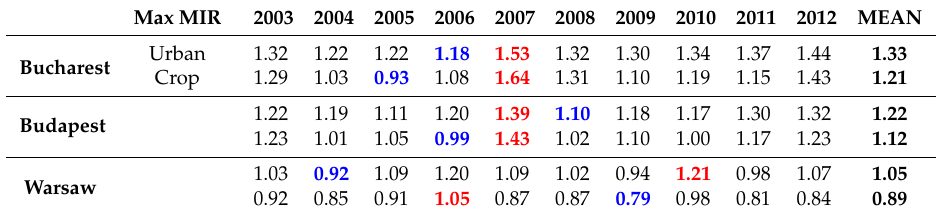
Table 3. The maximum values of MIR radiance from each year for urban and cropland class for three cities. Red indicates the highest value and blue indicates the lowest value in the time series.